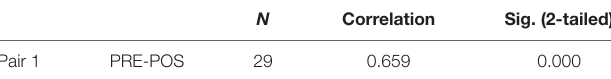
TABLE 10 | Pair samples correlations of the experimental group.